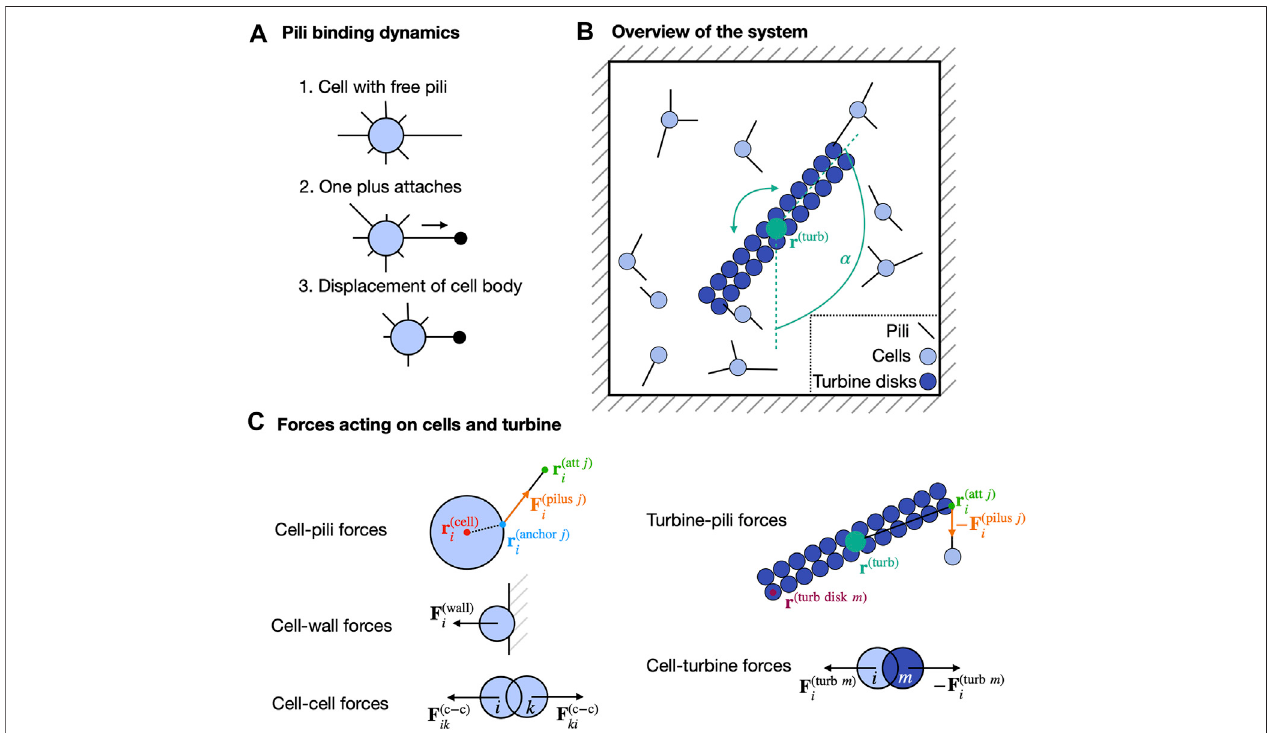
FIGURE1| OverviewofthecomputationalmodelofbacteriadrivingarotatableturbinebyattachmentoftypeIVpili. (A) Sketchofhowpilibindingandretractioncan lead to a force acting on a cell, a process reminiscent of a grappling hook. (B) Overview of the system. Cells are located in a box together with the rotatable turbine. The cellspossesspiliwhichtheyuseforthemotilityonthesubstrateandforattachmenttotheturbine.Theturbinecenterislocatedat r (turb) andhasanorientationde fi nedby the angle α . (C) Summary of all forces acting on the cells and turbine. Friction forces with the environment (surrounding liquid and substrate) are not